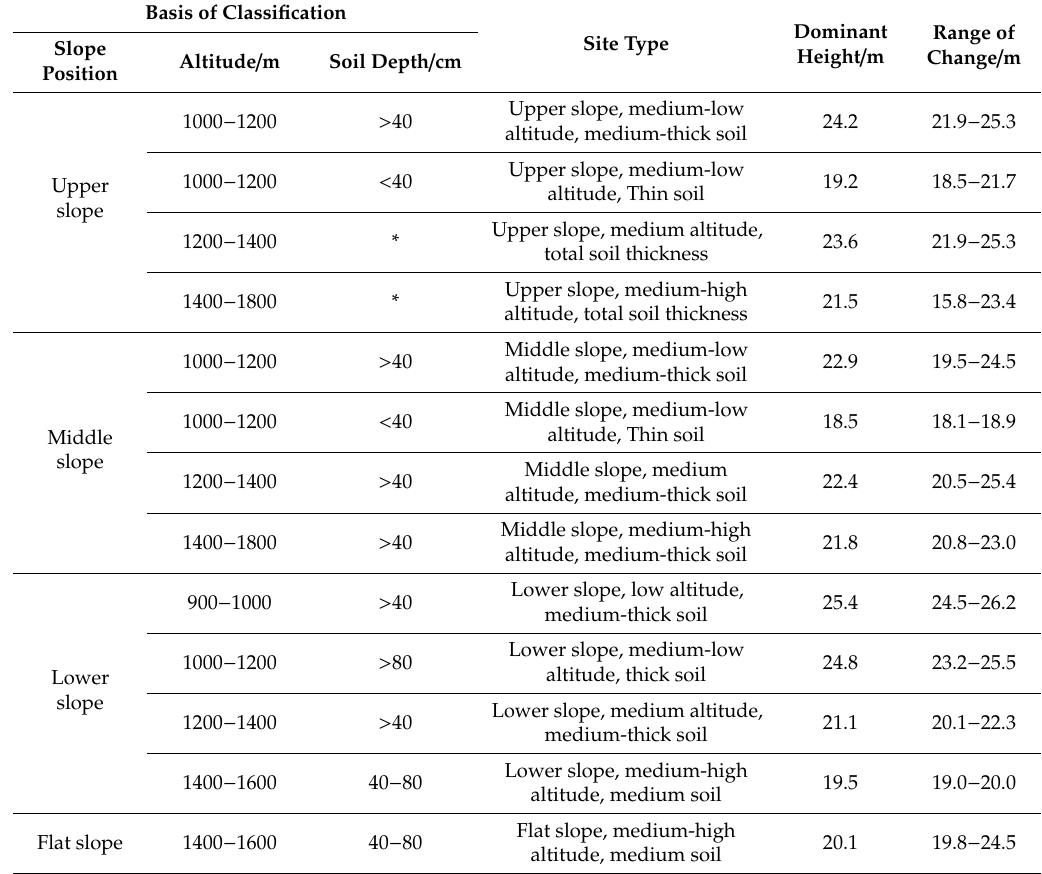
Table 4. Site classification of E. urophylla × E. grandis plantation in southern